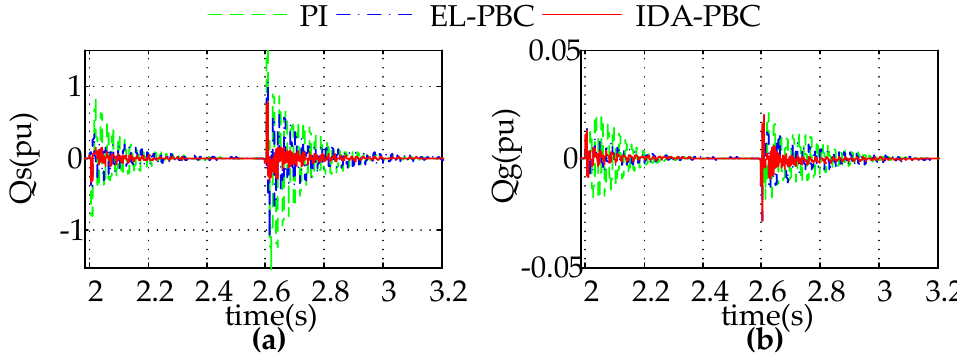
Figure 7. Suppressing the output reactive power fluctuation: ( a ) Stator reactive power; ( b ) Grid-side